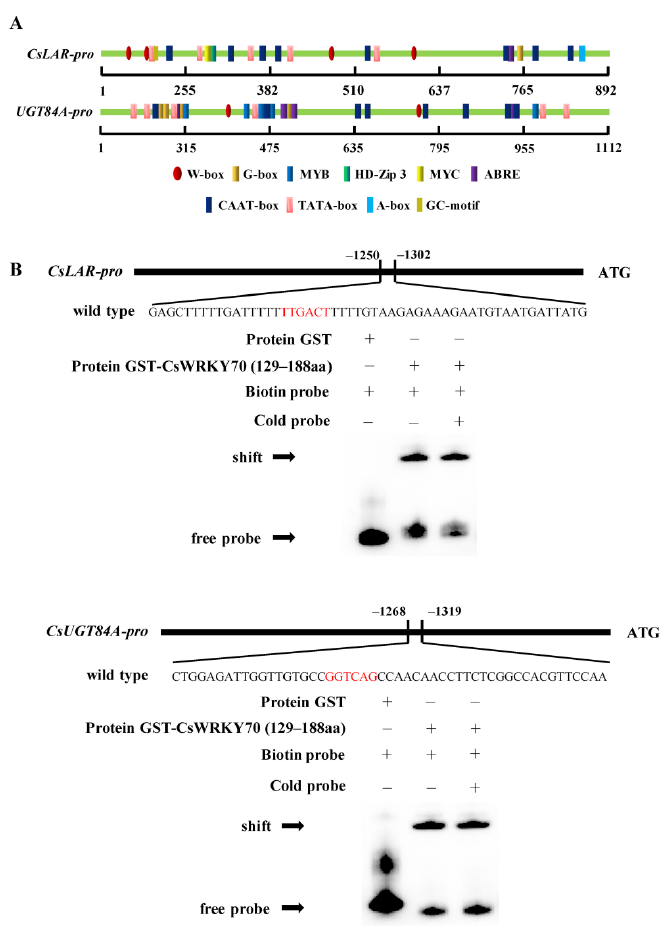
Figure 5. Cis -elements analysis of CsLAR and CsUGT84A promoters and electrophoretic mobility assays (EMSA) of CsWRKY70 binding to CsLAR and CsUGT84A promoters. ( A ) Prediction of cis - elements on the CsLAR and CsUGT84A promoters. Ellipses represent W-box elements that can bind to WRKY TFs. ( B ) Recombinant GST-CsWRKY70 fusion protein binds directly to the promoters of CsLAR and CsUGT84A containing the W- box (T/CTGACT/C). The DNA−protein complexes were separated on 6% native polyacrylamide gels. The ‘−’ and ‘+’ indicate the absence and the presence of specific proteins, respectively.